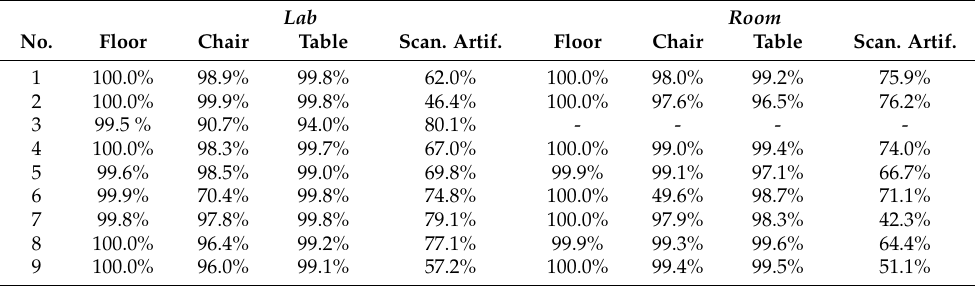
Table A6. Recall for the datasets Lab and Room , semantically segmented by Recap .